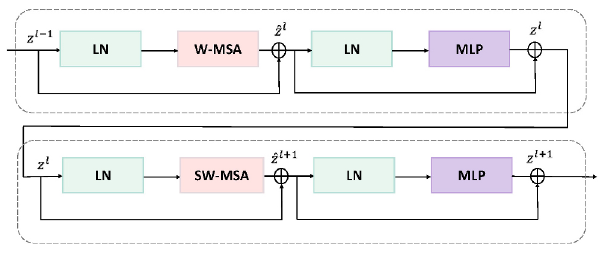
Fig. 3 A Swin transformer block [19]. LN: LayerNorm layer. W- MSA: window-based multi-head self-attention module. SW-MSA: shifted window-based multi-head self-attention